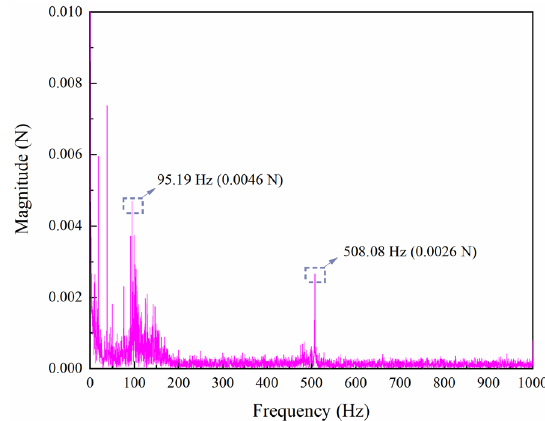
Figure 11 The frequency spectra of friction force signal measured in passive sliding against PTFE#3 with dominant frequencies of 95.19 and 508.08 Hz